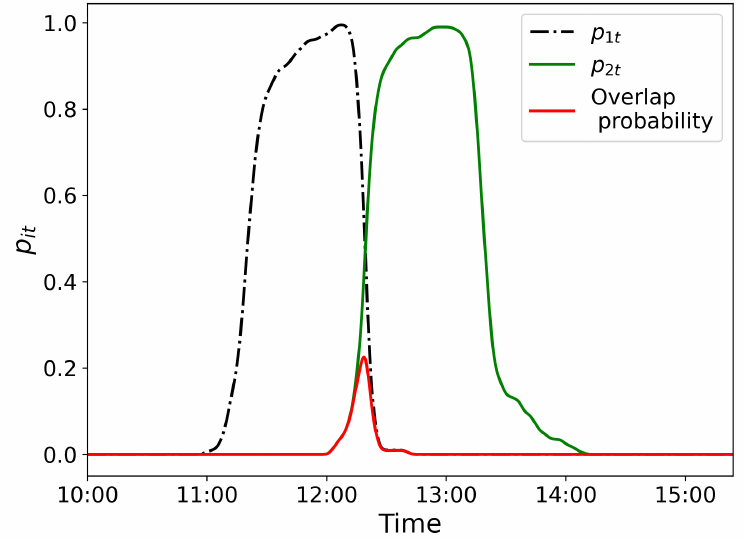
Figure 8. Aircraft presence probability ( p it ) of an aircraft with STA = 12:20 and STD = 13:10.